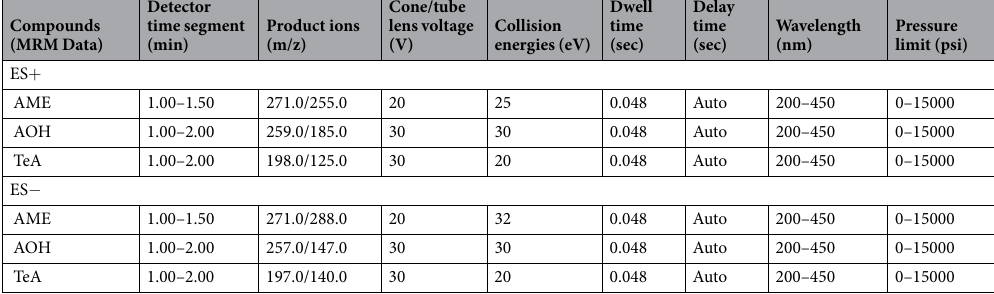
Table 5. MS/MS ion transitions, settings and ion ratio on Accucore RP-MS 100 × 3, 2.6 µ m, ACQ-TQD- QBB1152 instrument. Note: Ion mode: ESI; Ion polarity: positive and negative; AME, alternariol monomethyl ether; AOH, alternariol; TeA, tenuazonic